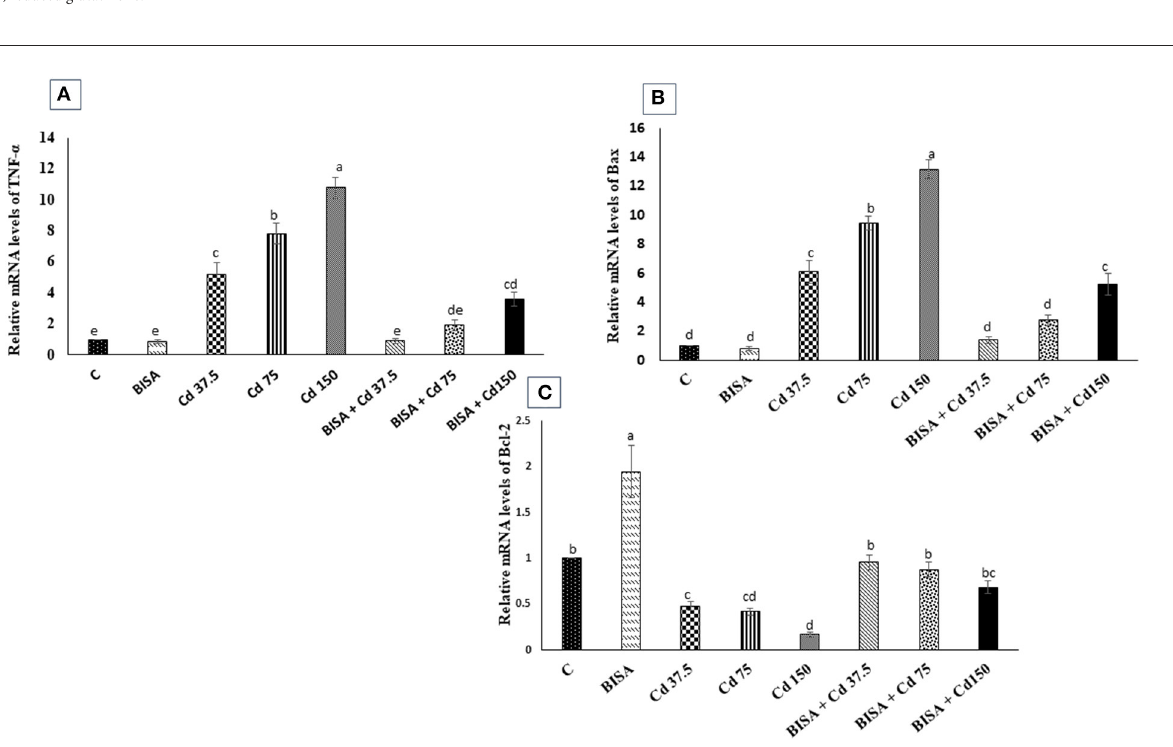
FIGURE4 Relative mRNA expression of tumor necrosis factor- α (TNF- α ) (A) , Bax (B) , and Bcl-2 (C) in the hepatic tissue of ducks in response to oral administration of α -bisabolol (BISA, 50 mg/kg/day) and/or CdCl 2 at 37.5, 75, or 150 mg/kg diet) for 4 weeks. Data are displayed as mean ± SEM ( n = 6 ducks). Bars carrying different letters are significantly different from one another ( p < 0.05). C,